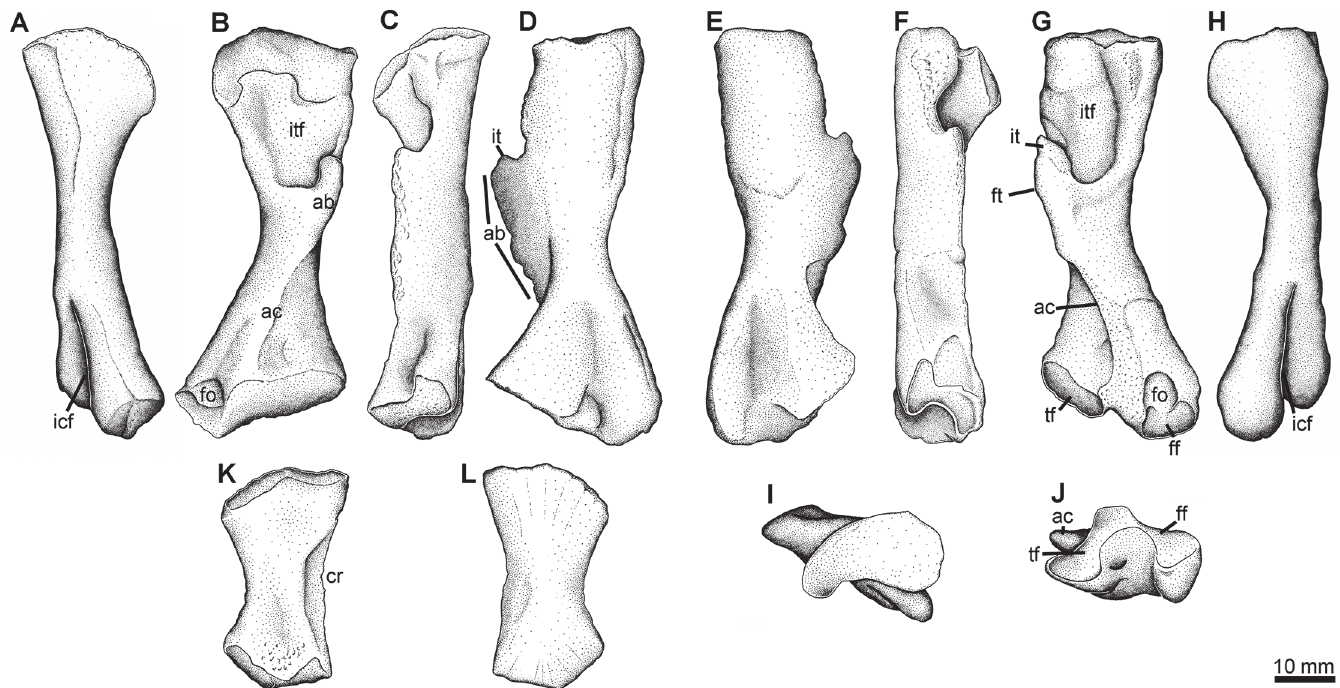
Fig 9. Femur Type 2 and tibia Type 1. NSM004GF045.034A-C, right and left femora (Type 2) and left tibia (Type 1) found in association. A-D, I, J, left femur in A, posterior, B, ventral, C, anterior, D, dorsal I, proximal, and J, distal views. E-H right femur in E, dorsal, F, anterior, G, ventral, and H, posterior views. Left tibia in K, flexor (ventral), and L, extensor (dorsal) views. Abbreviations : ab , adductor blade; ac , adductor crest; cr , thin anterior crest; ff , fibular facet; fo , fibular fossa; ft , fourth trochanter; icf , intercondylar fossa; it , internal trochanter; itf , intertrochanteric fossa; tf , tibial